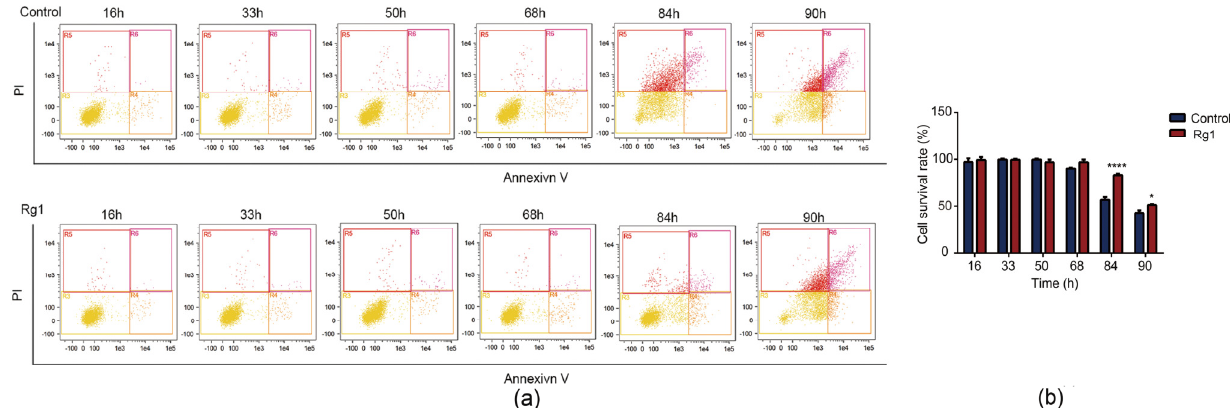
Figure 3. Rg1 delays apoptosis of S. cerevisiae cells. ( a ) The percentage of apoptotic cells was detected by flow cytometry. ( b ) Quantification of normal analysis from panel a. Data are expressed as the mean ± SD; n = 3. Compared with untreated controls, * p < 0.05, **** p < 0.0001.